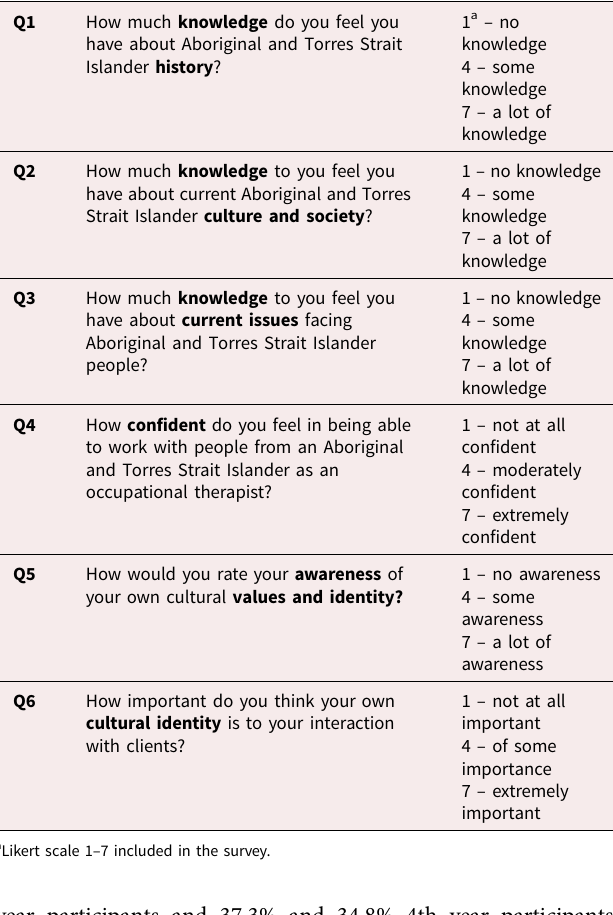
Table 1. Survey questions compared pre and